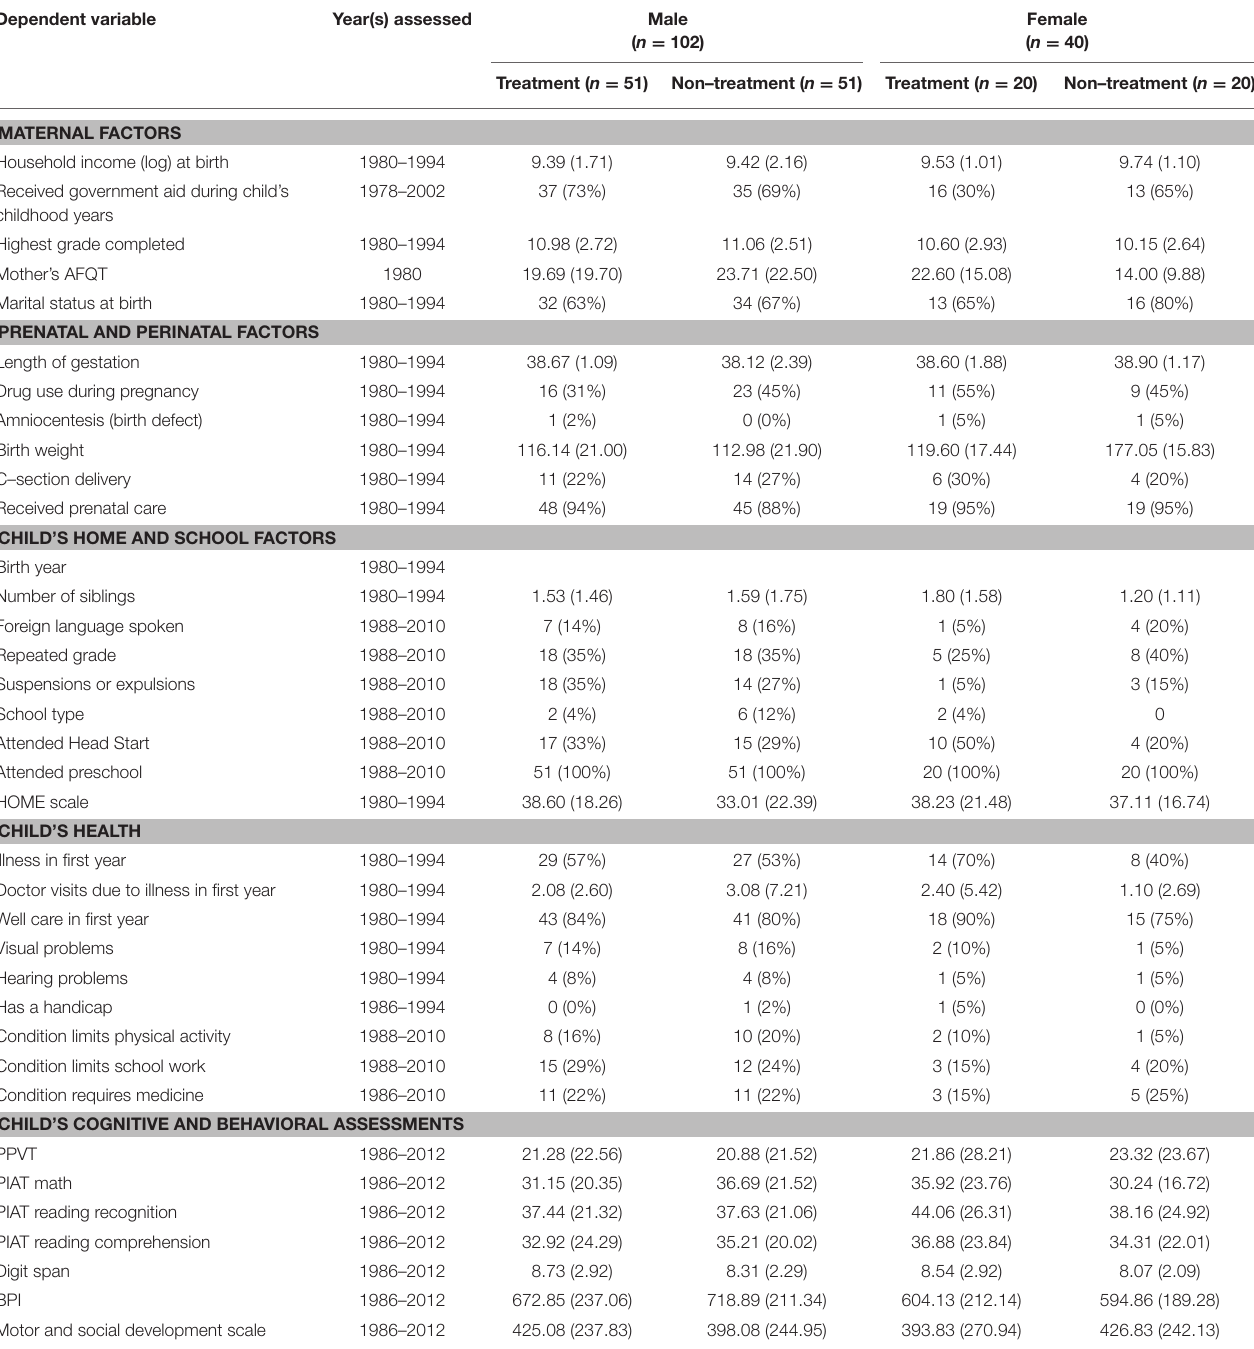
TABLE 2 | Dependent variables used in calculating propensity score and balance check for hispanics ( n = 142). Dependent